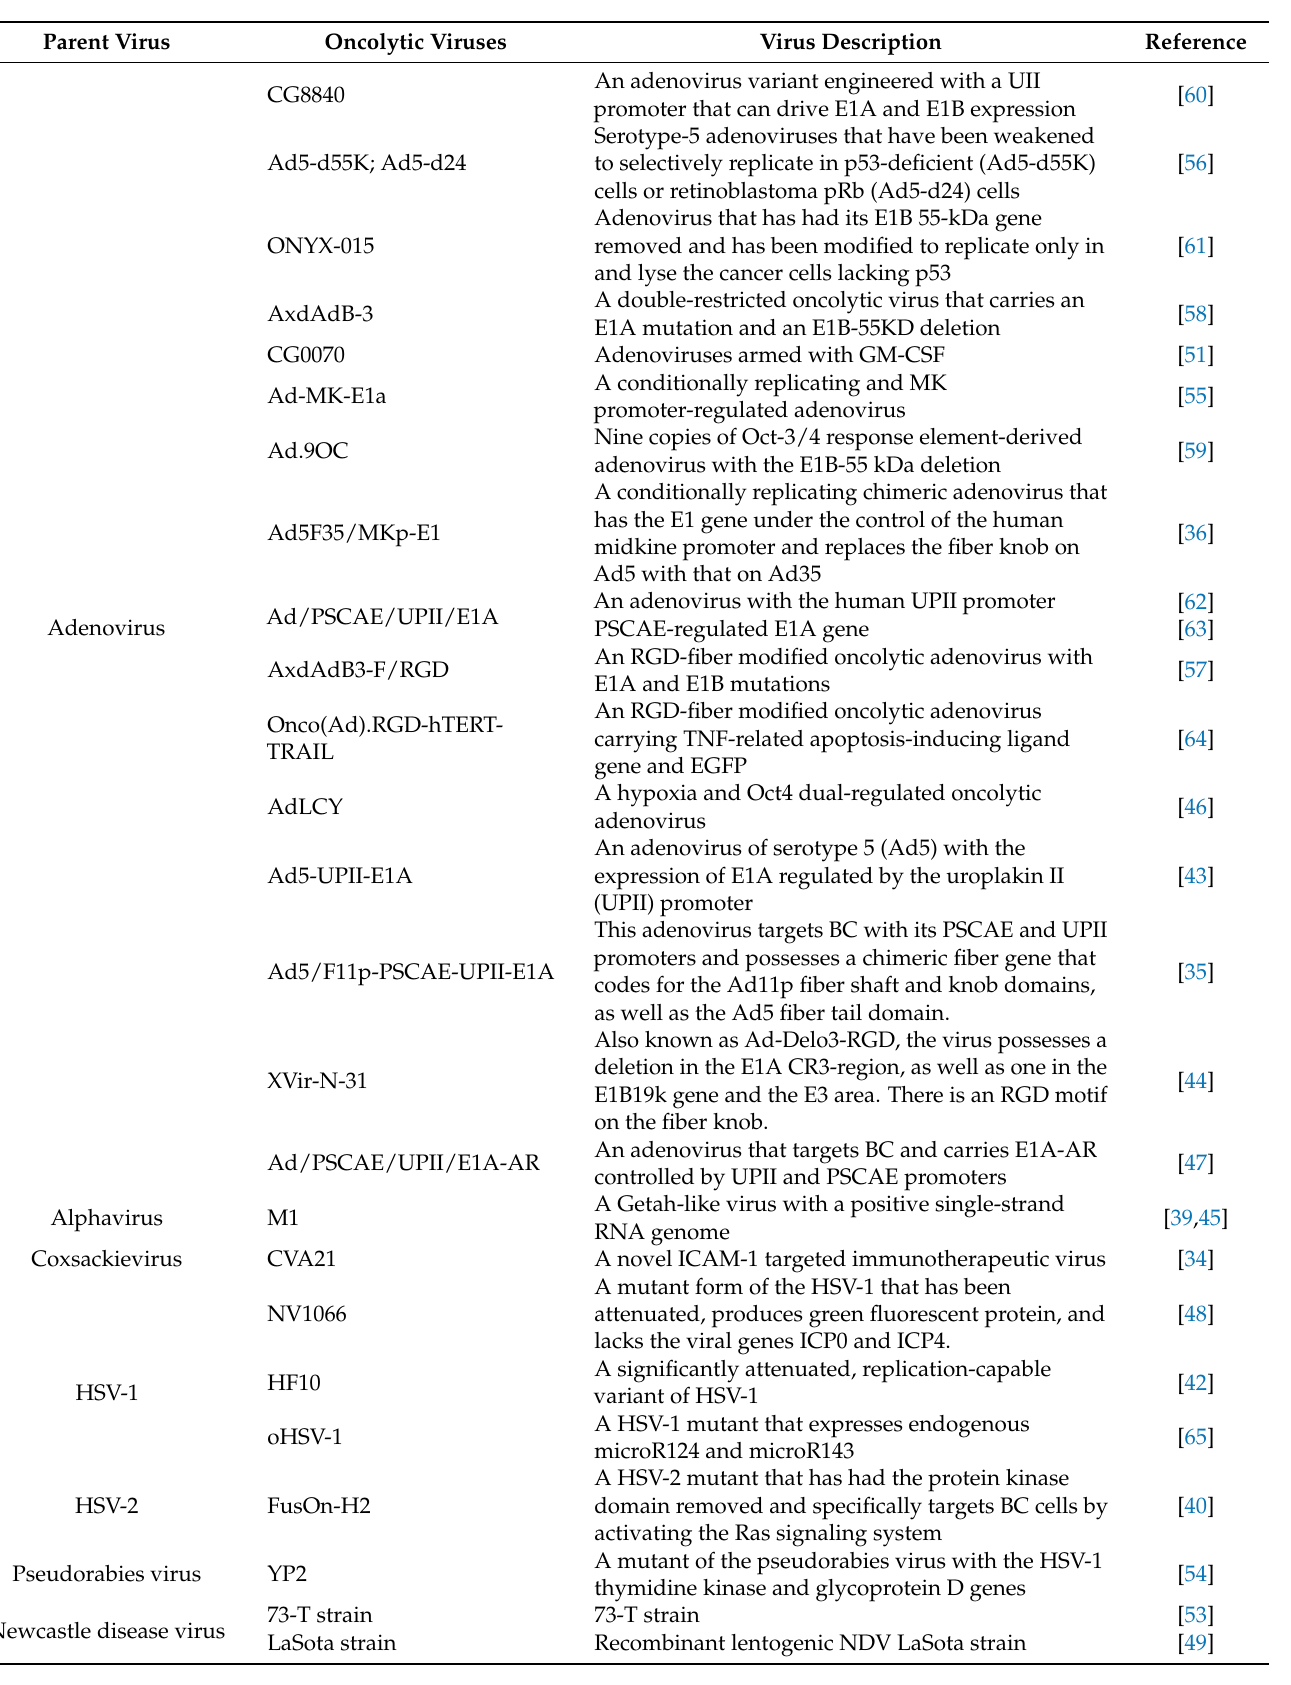
Table 1. Preclinical studies on oncolytic viruses for Bladder